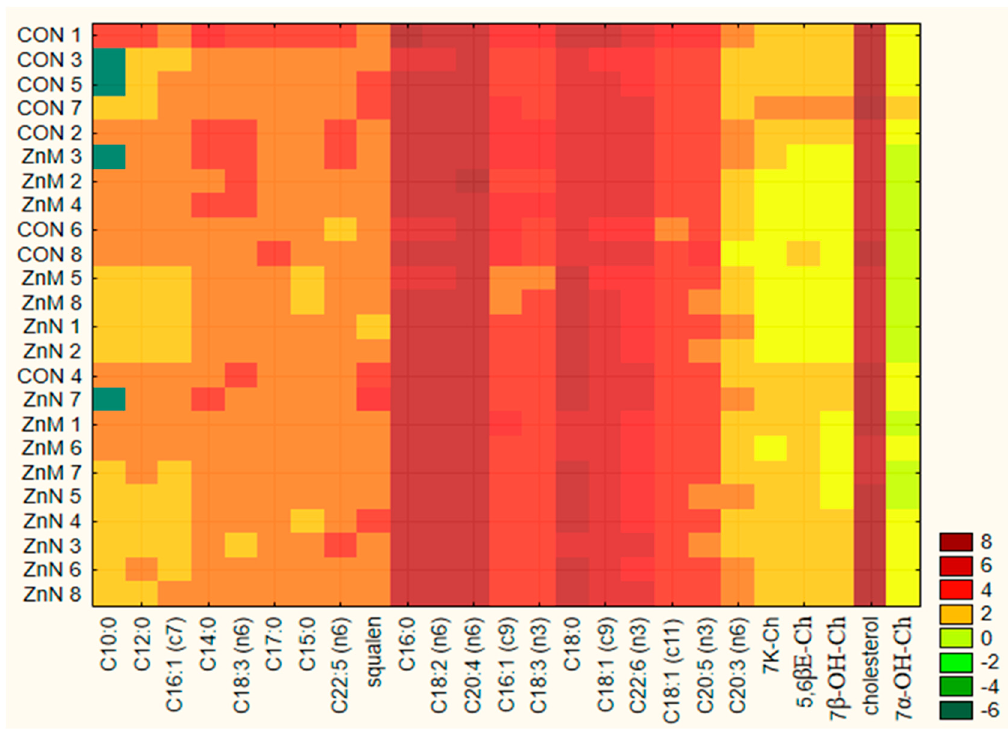
Figure 2. Heatmap for the overview: comparison of fatty acids, squalene, cholesterol and its oxidized derivatives in serum of individual rats.